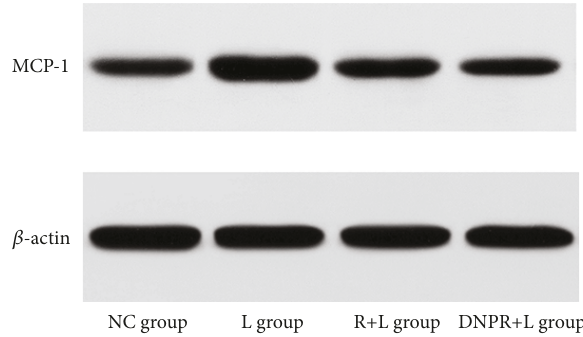
Figure 3: E ff ects of LPS and LPS/CCR2 antagonist interventions on the expression level of MCP-1 by Western blot. The result of Western blot shows that under LPS stimulating the expression is upregulated, and direct administration of RS102895 can reduce the expression of MCP-1 to some extent but not to the condition without LPS stimulating. Nanoparticles can signi fi cantly reduce the MCP-1 expression.